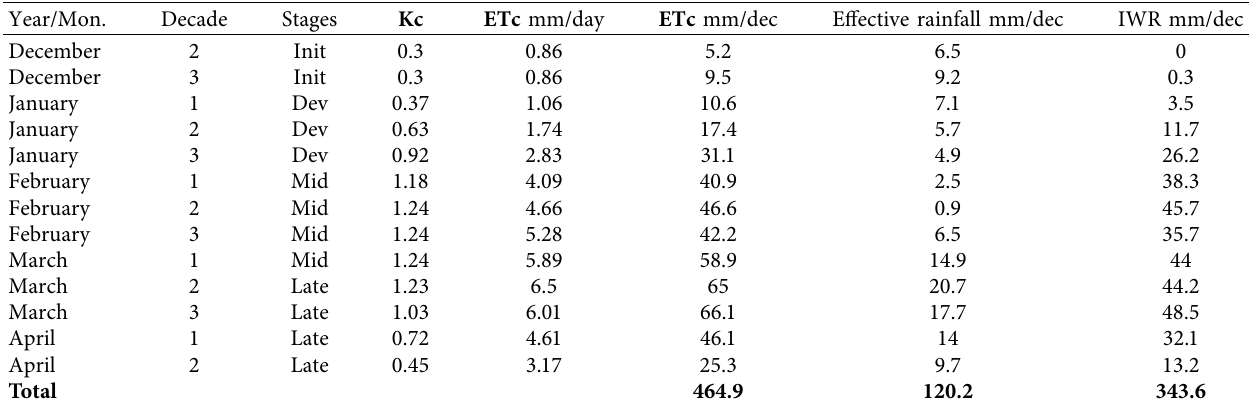
Table 5: CWR of maize (grain) at different stages.